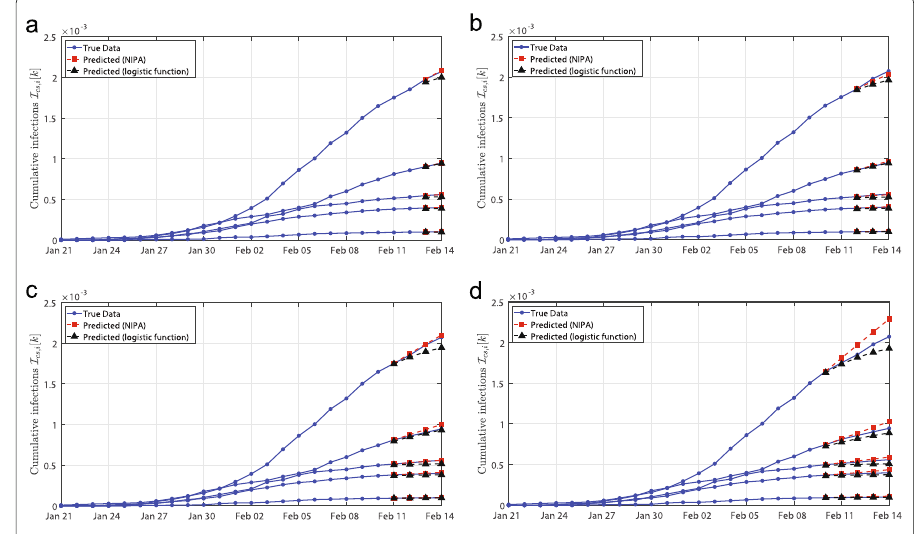
Fig. 2 Prediction of the COVID-19 outbreak in Hubei . The prediction of the COVID-19 outbreak in Hubei by NIPA and by simple logistic regression. For clarity, only five of the N = 16 cities are depicted. Each subfigure is obtained by omitting a number m = 1,2,3,4 of days prior to February 14, 2020, and subsequently predicting the same number of days ahead in time. The omitted number of data points is equal to: a m = 1 day, b m = 2 days, c m = 3 days and d m = 4 days. The first prediction data point, for